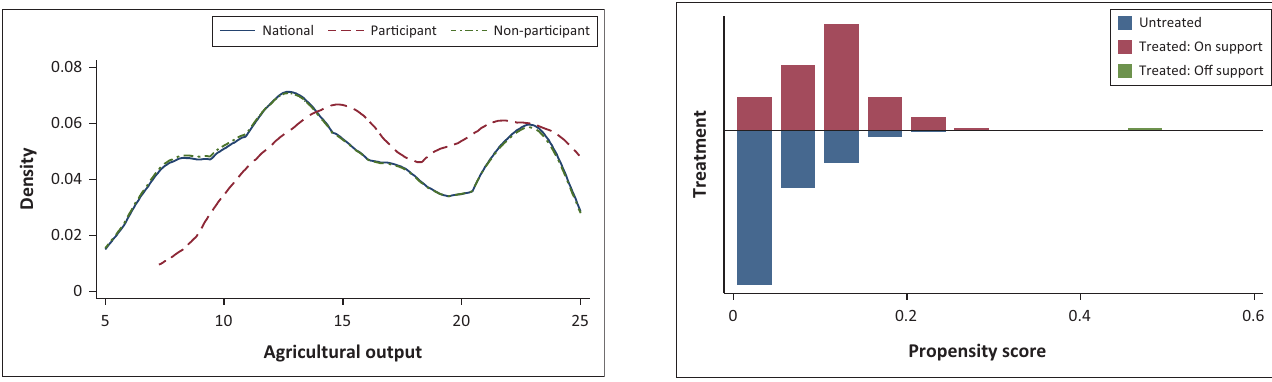
FIGURE 3: Kernel density plot of agricultural credit. FIGURE 4: Propensity score distribution. TABLE 2: Comparing household characteristics of propensity score match (Outcome variable: agricultural production). Agricultural credit Households with agricultural (with = 1, without = 0)